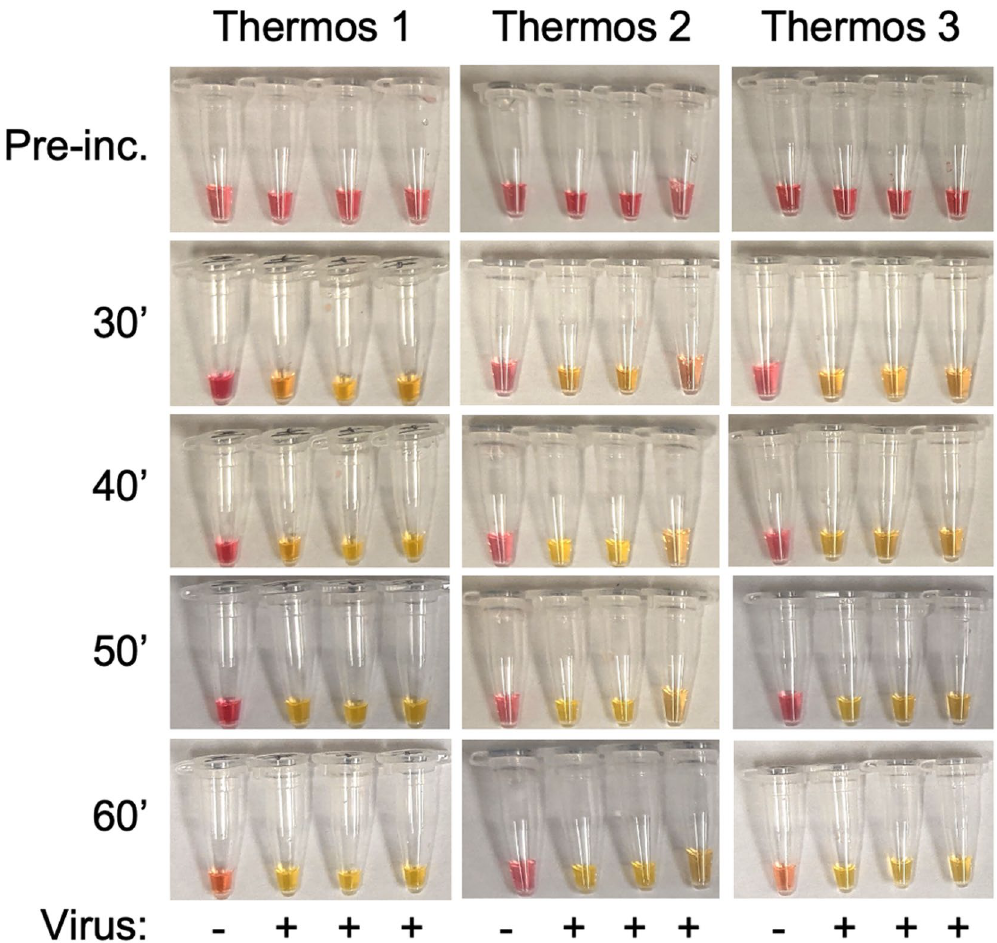
Figure 5. Validation of the RT-LAMP home test in different commercially available thermoses (see Methods for thermos details. Viral strain: Inactivated SARS-CoV-2 A (WA-1/2020) in gingival swab media. One non-template control (gingival swab media only) and triplicate virus, (−) and ( +) respectively, per thermos